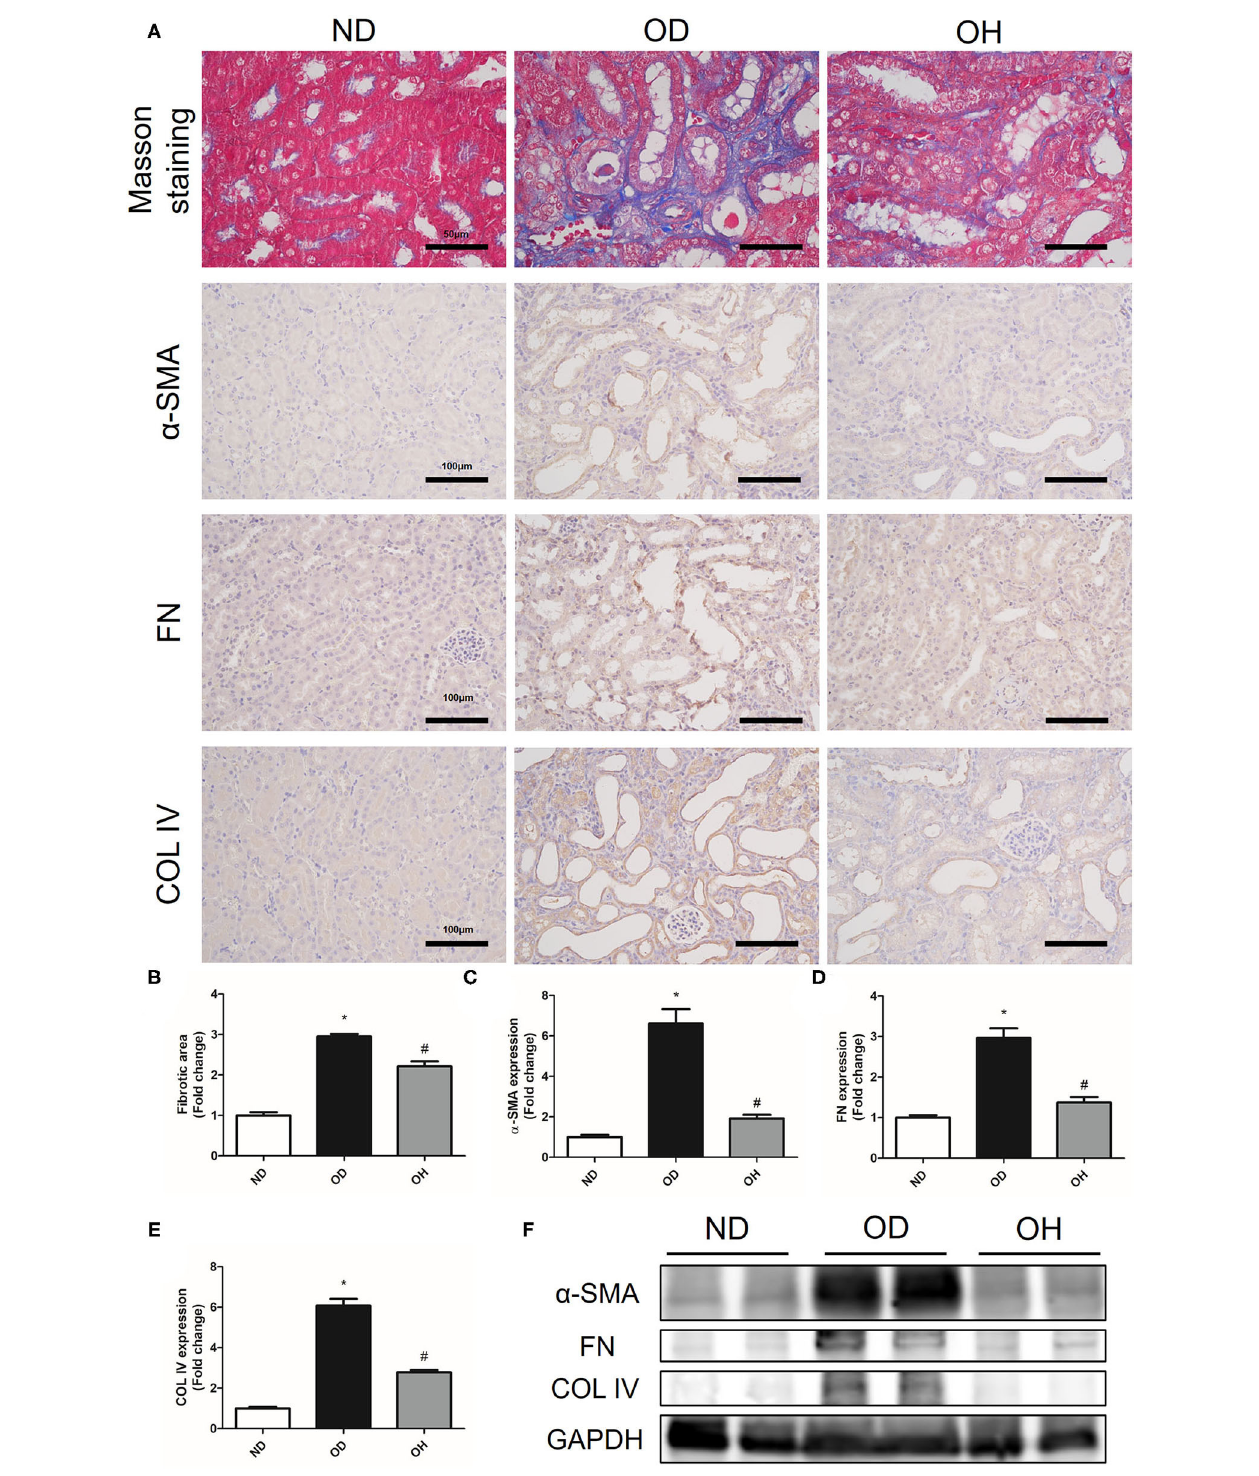
FIGURE 3 | HRW administration alleviates oxalate-induced renal fibrosis in mice. (A) The degree of renal collagen was assessed with Masson trichrome staining (Scale bar = 50 µ m); The protein expressions of α -SMA, FN, and COL IV in kidneys of mice were detected by immunohistochemistry (Scale bar = 100 µ m). (B–E) Corresponding semiquantitative analysis of Masson trichrome staining and α -SMA, FN and COL IV immunohistochemistry staining. (F) The protein expressions of α -SMA, FN and COL IV in kidneys of mice were detected by western blotting. The results were expressed as mean ± SEM. Statistical comparisons were performed using a NewmanKeuls test (* p < 0.05 vs. ND group, # p < 0.05 vs. OD group).